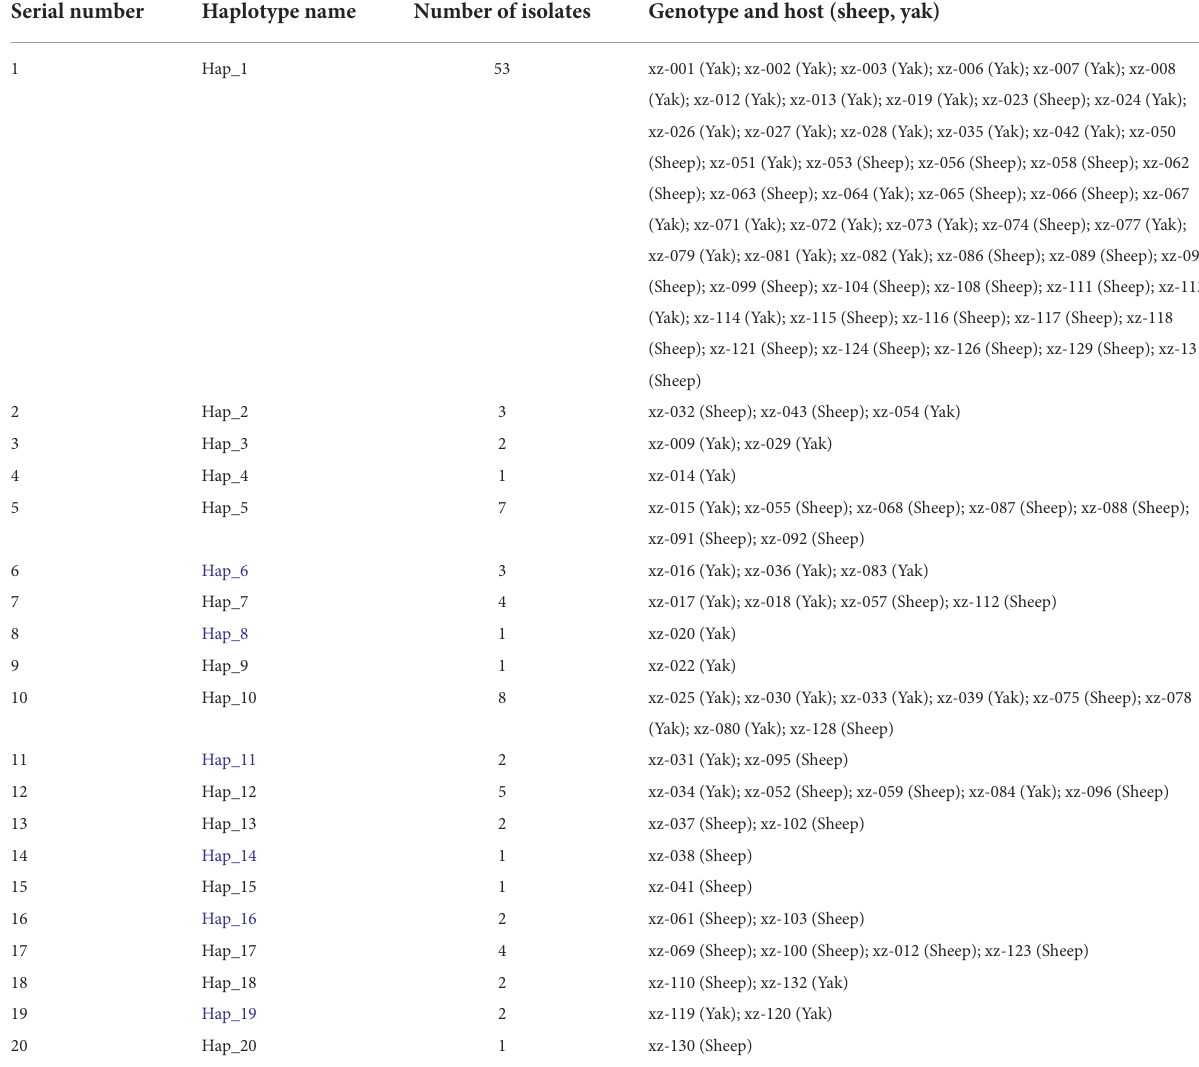
TABLE 1 Haplotype assignment and sample distribution of cox 1 gene